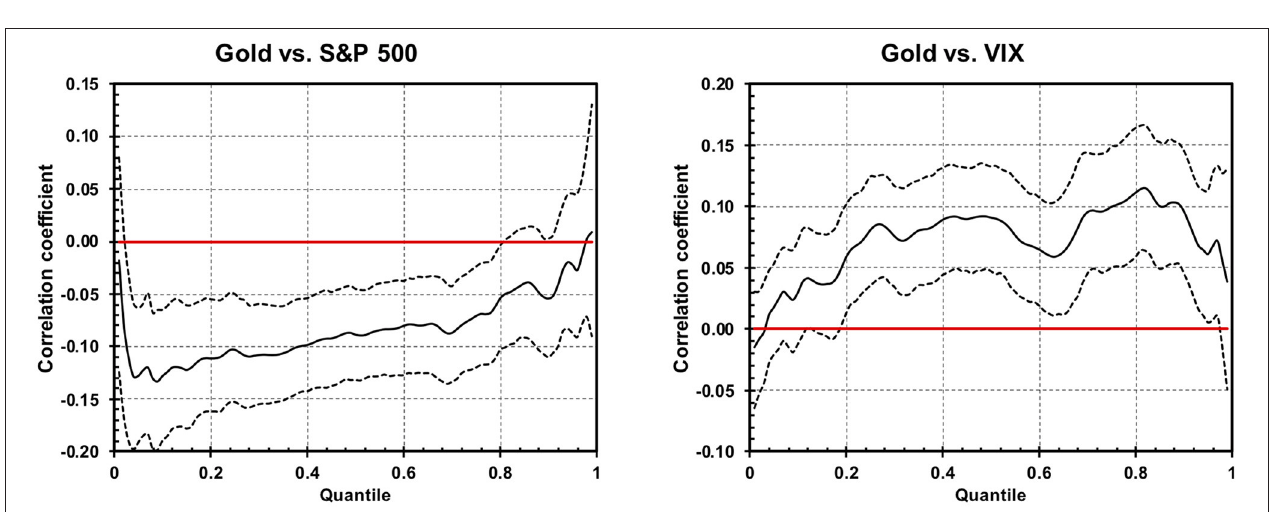
FIGURE 3 | Quantile correlations for gold. (Left) Quantile correlations between gold and the S&P 500 index. (Right) Quantile correlations between gold and the VIX index. The notation from Figure 2